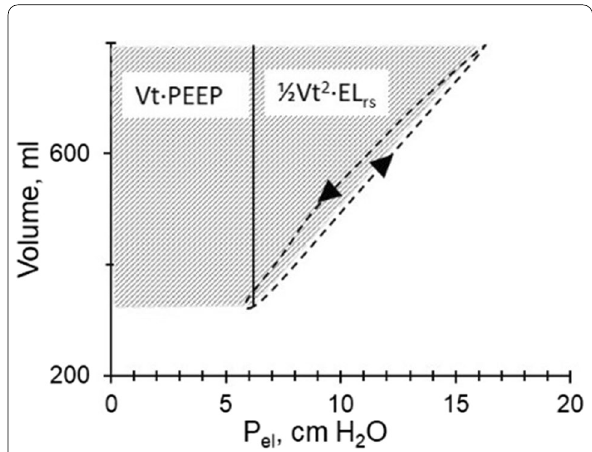
Figure 1. The loop, interrupted line, represents inspiratory and expira- tory Pel during a breath. The loop area represents the elastic work lost Figure 1. Graphical representation of the course in amounts of fluid in the lung during the breath, Wel,lost. The total inspiratory elastic (in mL/day) of the different fluid groups over 10 days of invasive work, Wel,tot, hatched area, covers the components Vt PEEP, the · rectangle and ½Vt2 ELrs, the triangle. ELrs is elastance of the respira- · tory system.